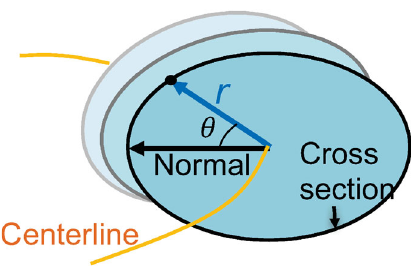
Fig. 5 Relative curvature condition.